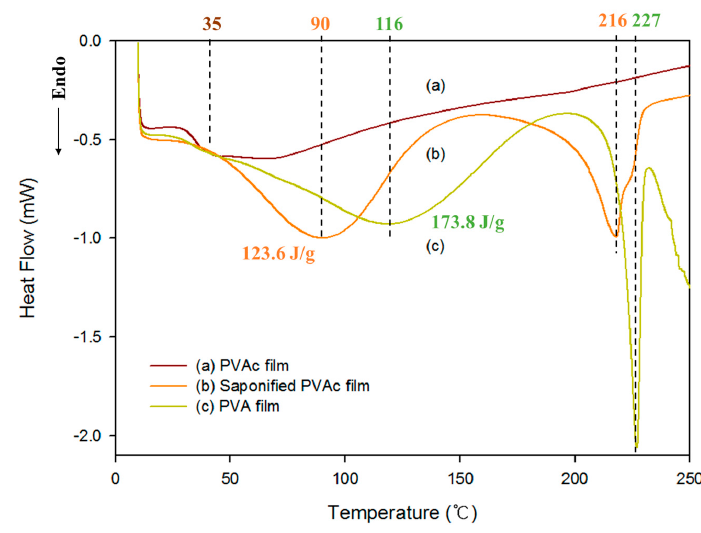
Figure 5. DSC curves for the (a) pure PVAc film; (b) PVAc film obtained by heterogeneous saponification at 50 °C for 96 h; and (c) general PVA film.